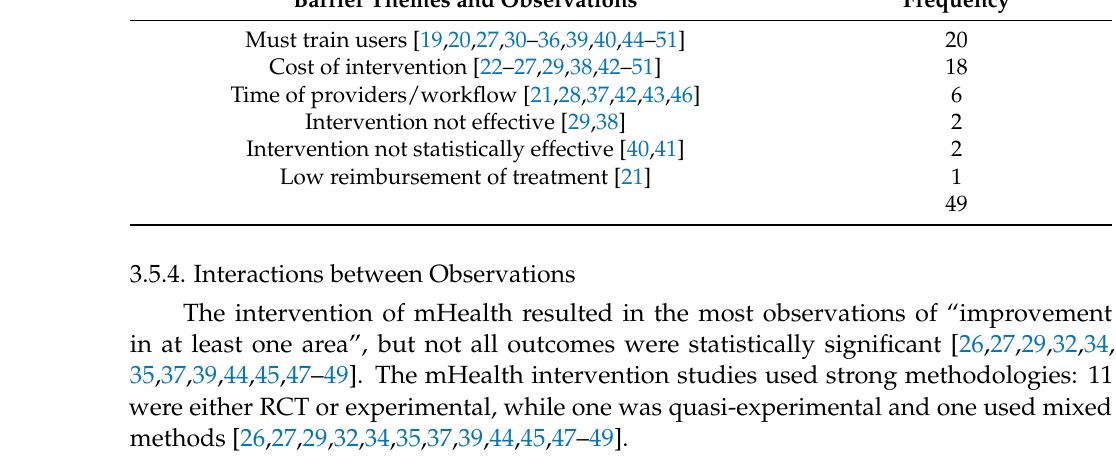
Table 5. Barriers to the adoption of Telehealth for the treatment of Breast Cancer. Barrier Themes and